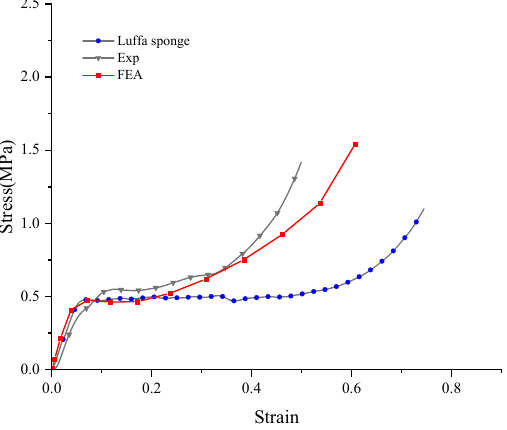
Figure10. Stress-straincurvesof lu ff asponge, TPU,experimentand finiteelementanalysis